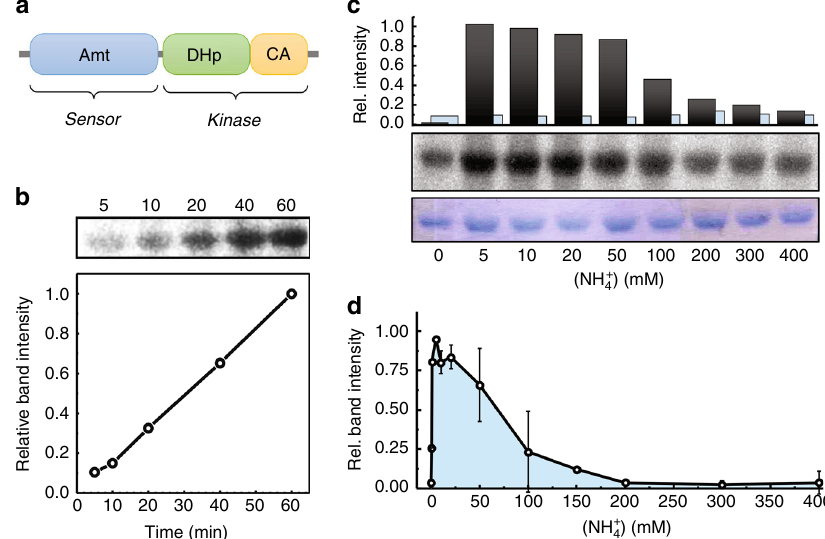
Fig. 1 Architecture of Ks -Amt5 and its kinase activity. a The ammonium sensor/transducer Ks -Amt5 comprises a membrane-integral sensor domain (Amt) and a soluble, C-terminally fused histidine kinase, consisting of a DHp and a CA subdomain. b With [ γ - 32 P]-ATP, the isolated HK domain alone shows increasing, but unregulated autophosphorylation over time. c In contrast, only full-length Ks -Amt5 reacts to variations in [NH 4 + ] and shows rapidly increasing phosphorylation levels (black bars) at low [NH 4 + ] that drop again at higher concentrations, whereas protein levels (Coomassie-stained, blue bars) remain constant. All data points were measured after 60 min incubation. d In an average of multiple ( n = 5) experiments on a linear time scale, variations in phosphorylation levels of residue H406 show the rapid response of Ks -Amt5 at low [NH 4 + ], followed by a slower decrease towards high concentrations of substrate, where passive diffusion of NH 3 can lead to unregulated permeation across the lipid